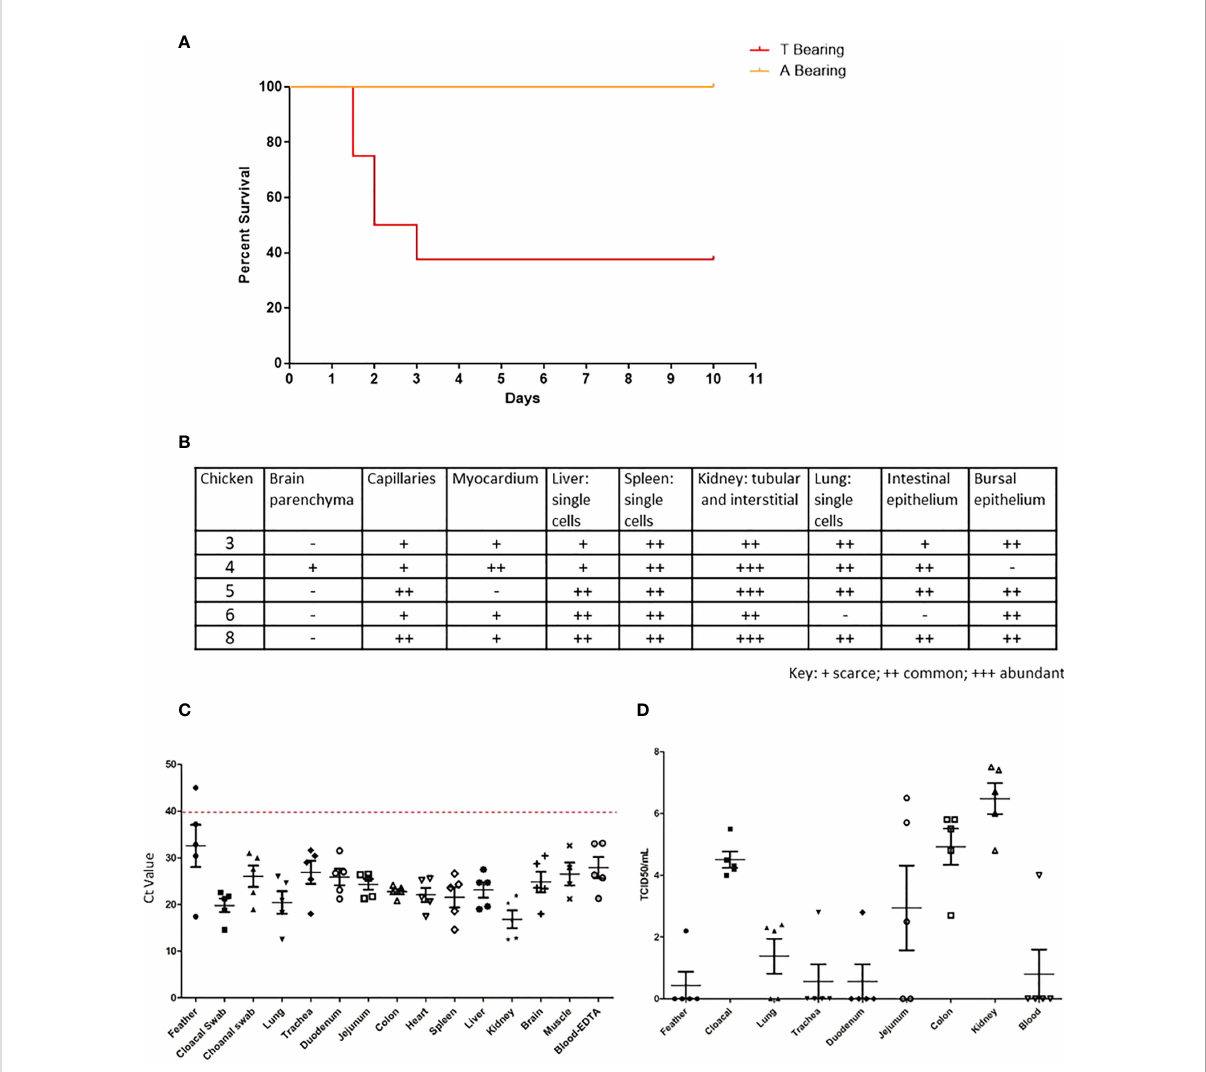
FIGURE 4 The 373T NP virus isolate causes severe disease and death but not the 373A NP. Survival curve (A) , RT-qPCR (B) histopathology scores, qPCR (C) and live virus detection (D) , of H7N9 systemic infection, following intravenous inoculation of SPF chickens with NP 373A and NP 373T bearing variants of A/Anhui/1/13 (H7N9). (A) Following inoculation of eight 16-week old SPF chickens with a 1:10 dilution of allantoic fl uid containing live A/Anhui/1/13 (H7N9) bearing NP 373T, fi ve chickens were humanely killed between day 2 and 3 pi. In contrast,